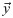
Restricted Boltzmann Machine.In training, the optimal values for weights W, U, which define the relations between visible variables x and hidden variables h, h and the class label y→, respectively, and b, c, d, which are biases in x, h, and y→, respectively, are computed. When new test data is inserted, the model computes the class label y→ by using the learned parameters. We note that this figure was previously presented in [21] and is reprinted here for the description of RBM.